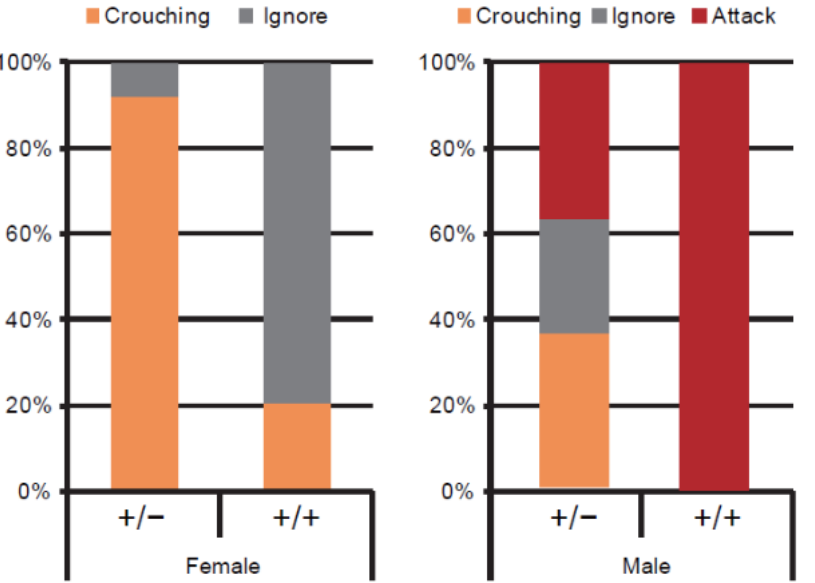
Figure 2. Cell-specific ablation of MCH neurons impairs nursing behaviour in both virgin female and male mice. Percentage of parental behaviour or attack pups of virgin MCH-tTA ; TetO DTA bigenic. +/+ and +/ − female ( left ) and male ( right ) mice. The ratio of parental behaviour (crouching) in female mice was analysed by Chi-squared test; X-squared = 9.56, df = 1, p = 0.002 (From Kato et al. [59]).